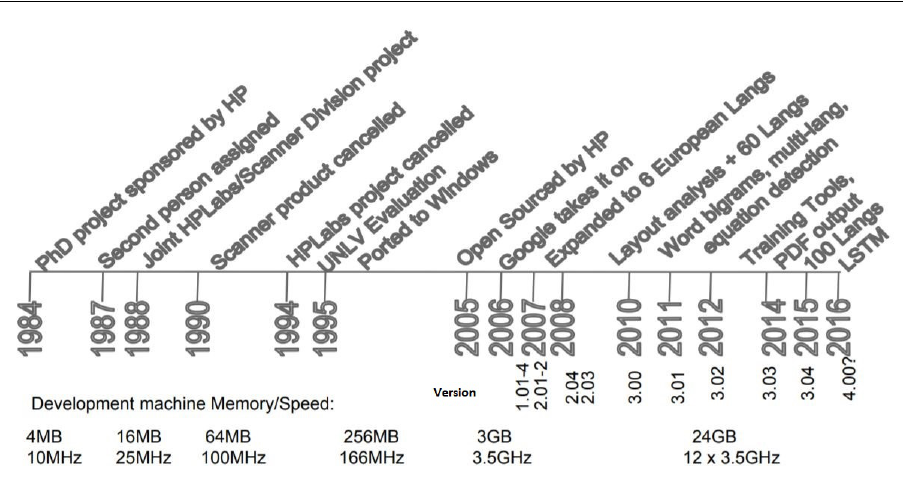
Figure 1. Tesseract Timeline